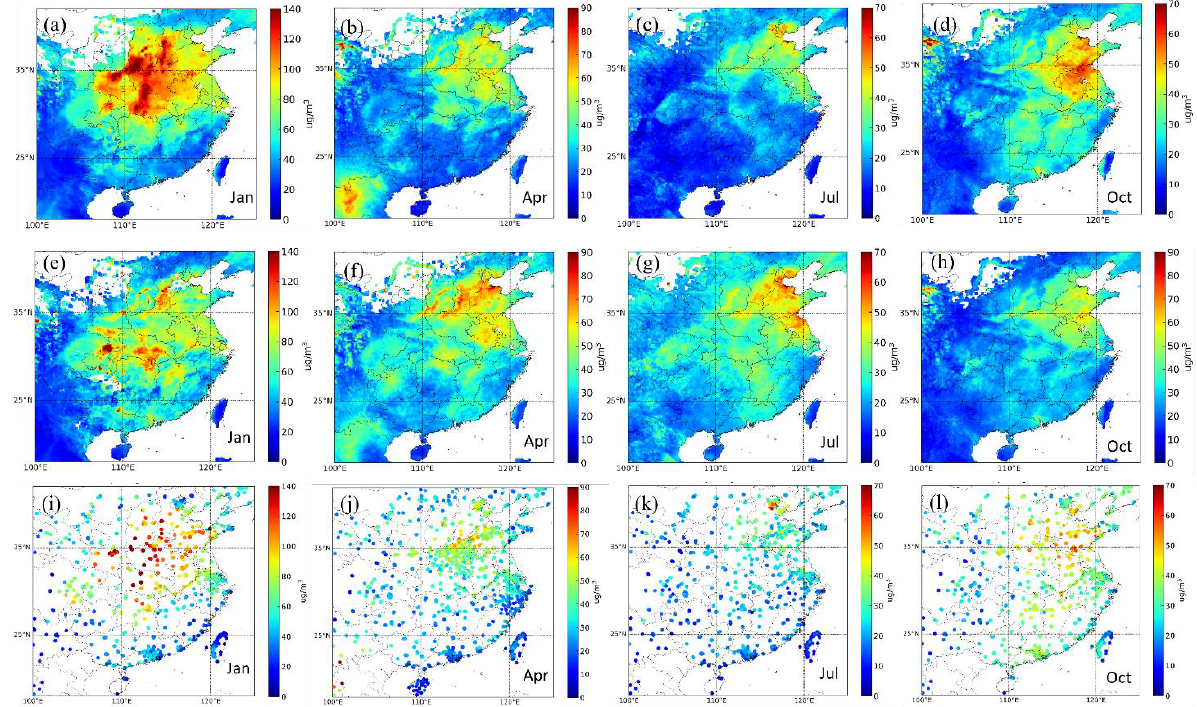
Figure 6. Spatial distributions of PM 2.5 in January, April, July, and October as modeled by the SEM and CSEN models. (( a – d ) CSEN; ( e – h ) SEM; ( i – l ) site observations).